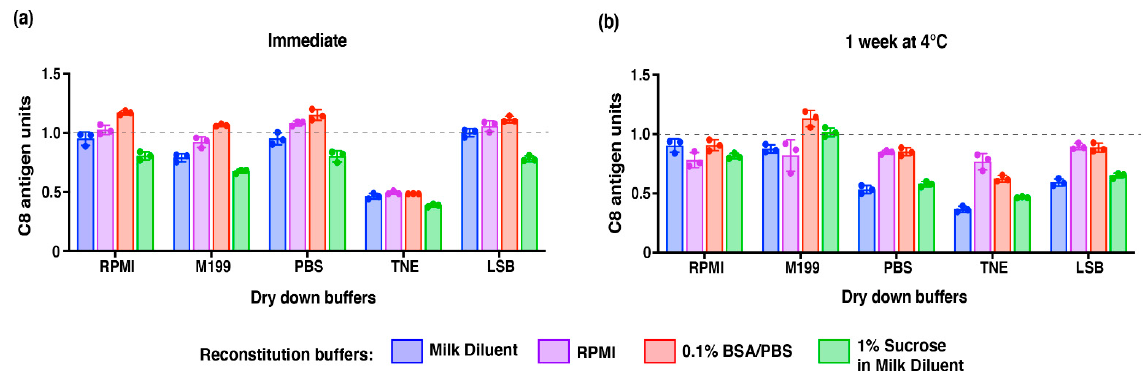
Figure 2. Optimization of drying and reconstitution buffers for 0.75% HSA/bDENV2. Briefly, 0.75% HSA/bDENV2 was dried on a 96-well plate using various buffers (RPMI, M199, PBS, TNE, and LSB) and reconstituted with different buffers (milk diluent, RPMI, 0.1% BSA/PBS, and 1% sucrose in milk serum) ( a ) immediately upon drying or ( b ) after 7 days of storage at 4 °C. Analysis was conducted using subtractive DENV E ELISA, and percentage recovery of bDENV2 antigen was normalized against a liquid stock control. Note: Error bars represent SEM from triplicate experiments. Dotted line across the graph represents 100% recovery of C8 antigen.